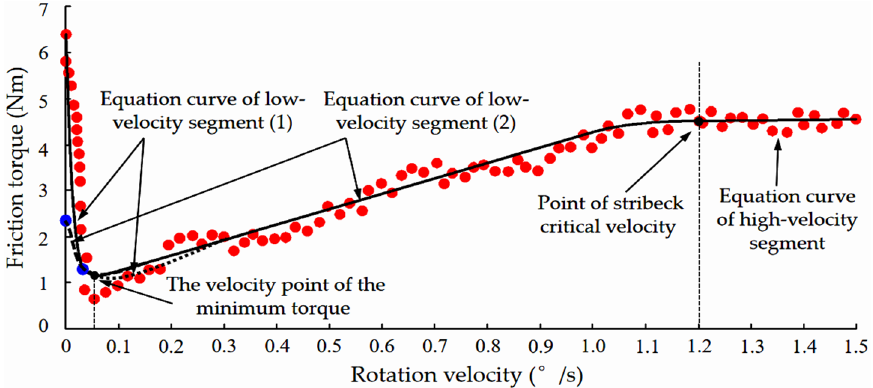
Figure 4. Fitting diagram of the cubic spline di ff erence